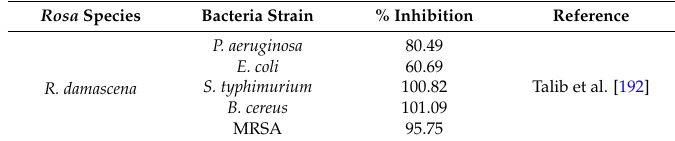
Table 5. Antibacterial effect of some Rosa species displayed as percentage of growth